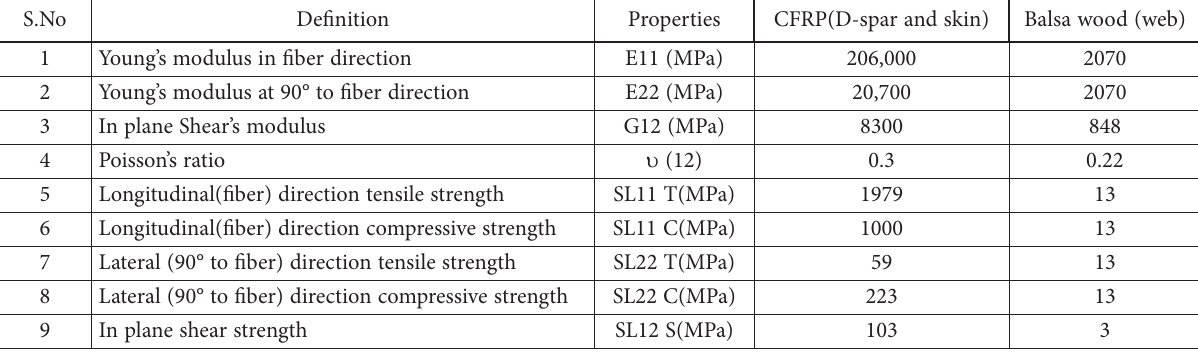
Table 2. Composite properties for the blade